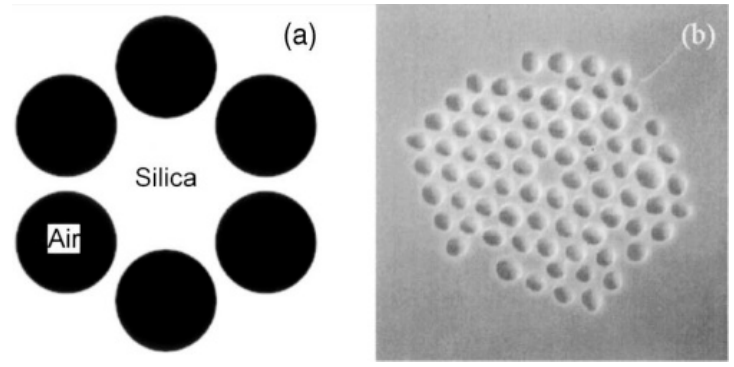
Figure 9. (a) Simulated MOF consisting of a 1.7 μ m diameter core surrounded by a ring of 1.4 μ m diameter air holes; (b) electron micrograph image of the inner cladding and core of the air–silica MOF. Reprinted with permission from [86] © 2000 Optical Society of America.